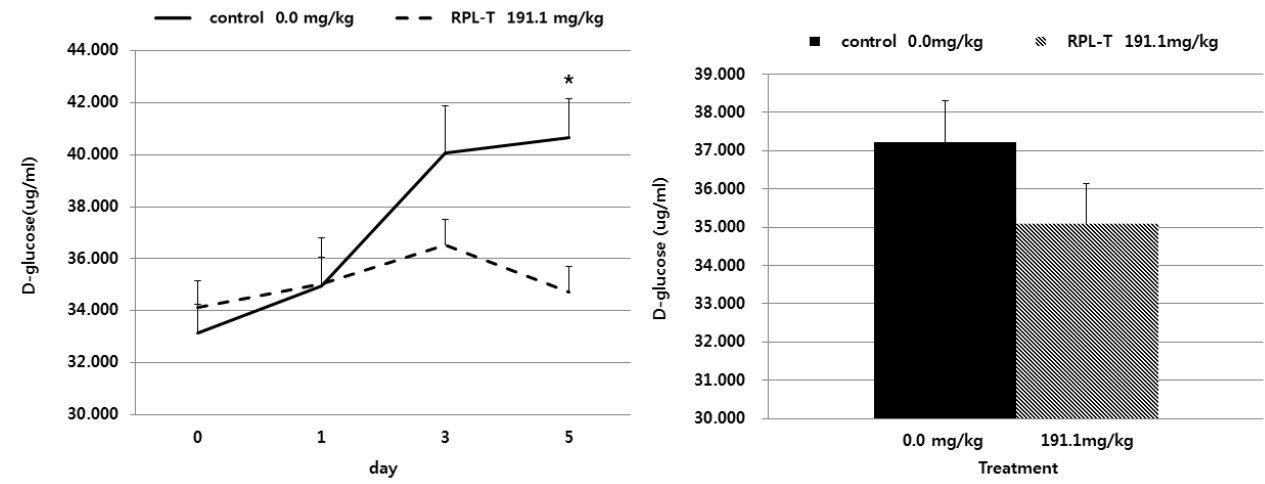
Figure 2. Effects of oral RPL-T on D-glucose content in feces of Korean native steers. RPL-T, rumen-protected L-tryptophan. Mean±standard error, * p<0.05 (Student's paired t-test, control vs RPL-T at 191.1 mg/kg body weight). — Control group, - - - RPL-T